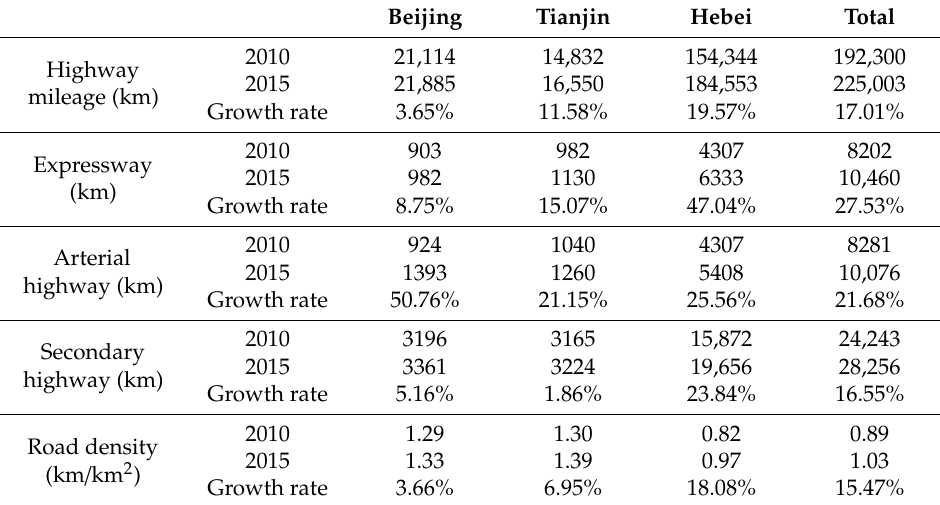
Table 3. Transportation network construction in the JingJinJi urban agglomeration.